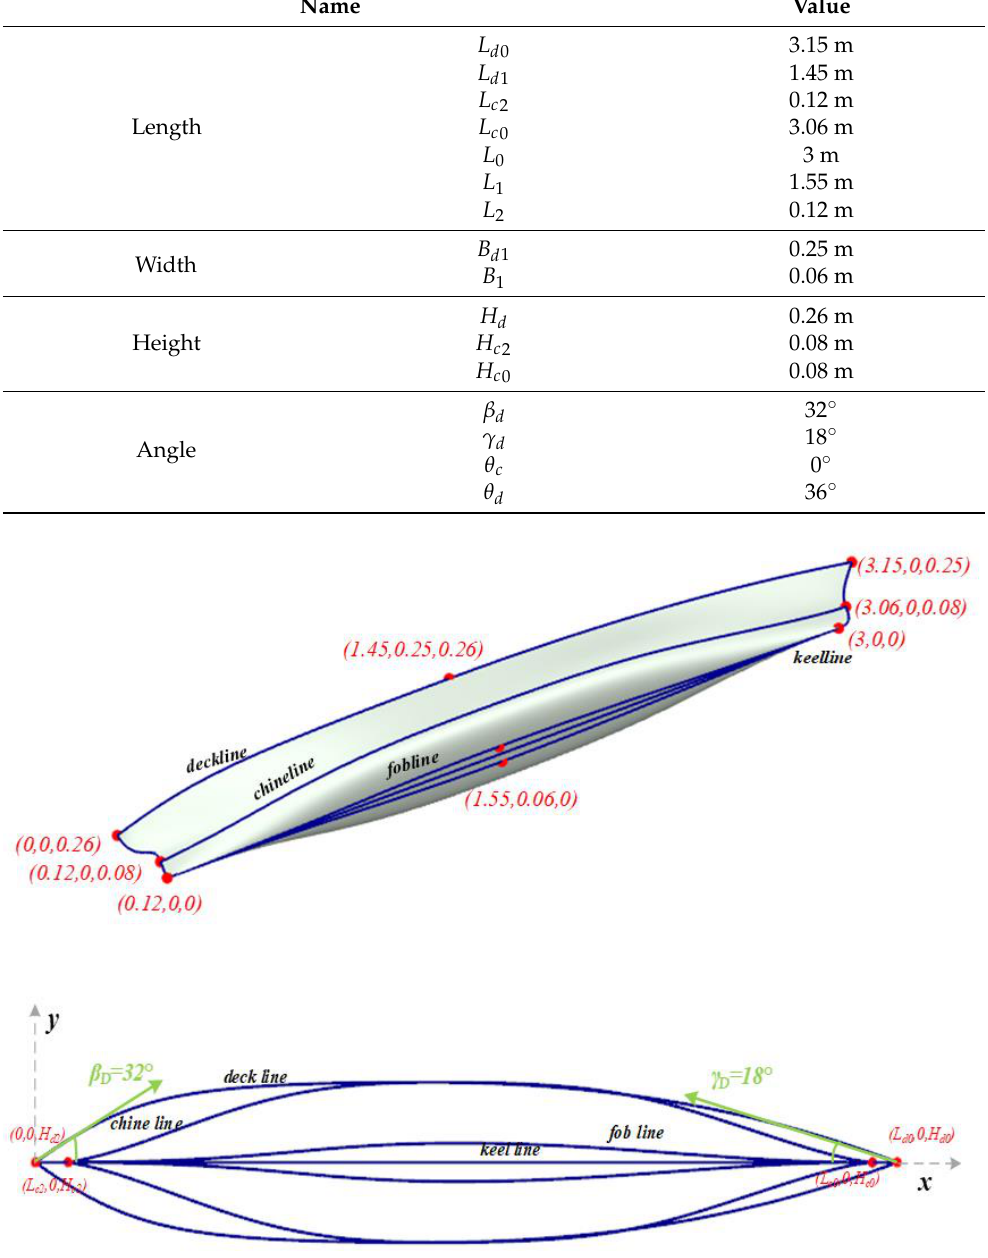
Figure 18. Schematic of the overall profile under constraints. The remaining 8 parameters, including δ b , W k , and δ f , were used as design variables, and the upper and lower limits of their variation were agreed upon, as shown in Table 4. Table 4. Boundaries of design variables used for sample generation.